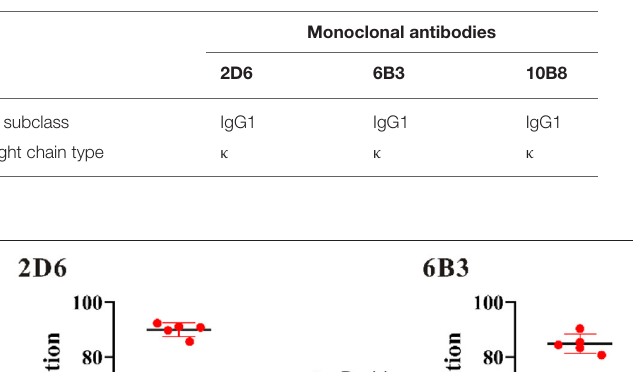
TABLE 1 | Identification of subclasses of p30 monoclonal antibodies.